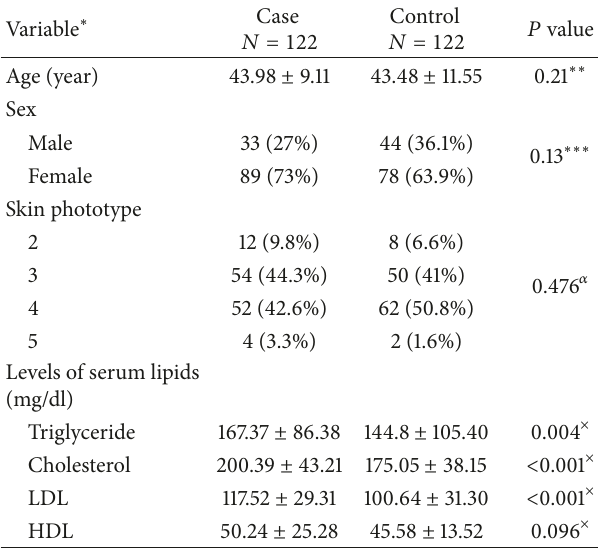
Table 1: Characteristics of participants in the case and control